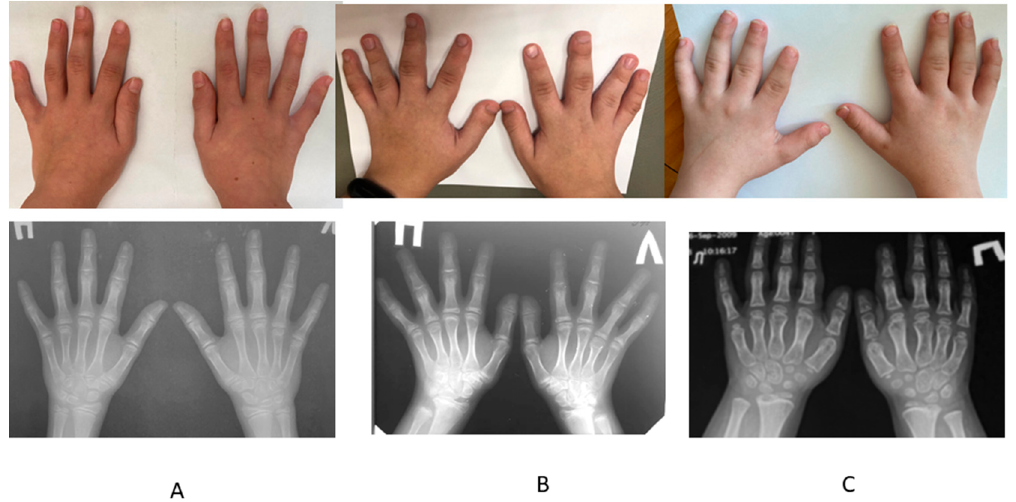
Figure 7. Photos and radiographs of the hands of the patients with different variants in the SLC26A2 gene. ( A ) Patient with the homozygous c.1957T > A (p.Cys653Ser) variant. ( B ) Patient with the compound heterozygous variant, c.1957T > A (p.Cys653Ser) and c. − 26 + 2T > C. ( C ) Patient with the compound heterozygous variant, c.835C > T ( р .Arg279Trp) and c. − 26 + 2T > C.